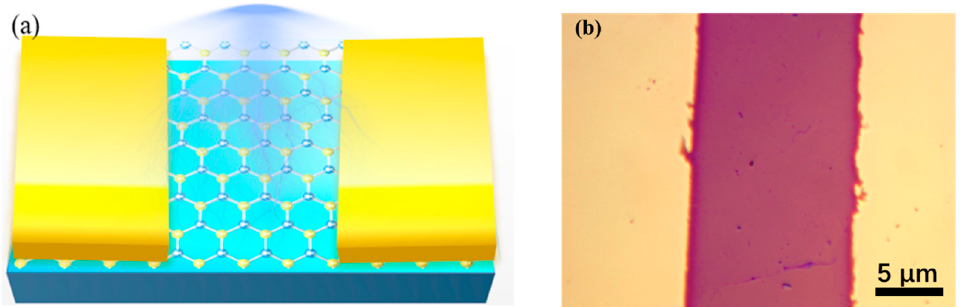
Figure 9. ( a ) Schematic and ( b ) optical image of the device.